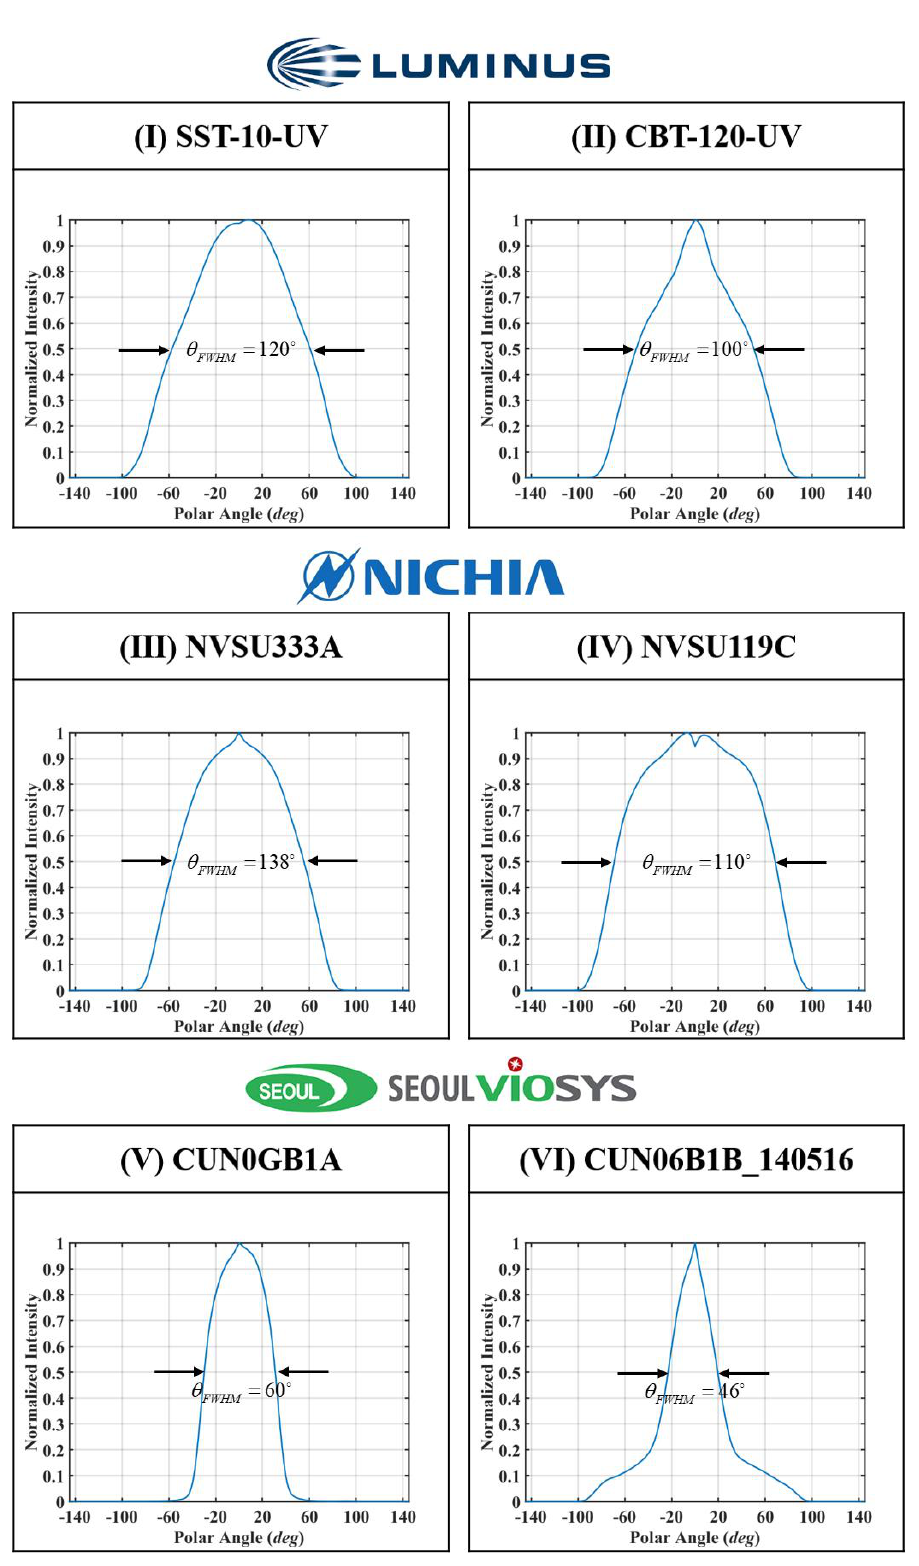
Figure 1. Radiation patterns or optical intensity directivities of the six chosen UV-LEDs ( I – VI